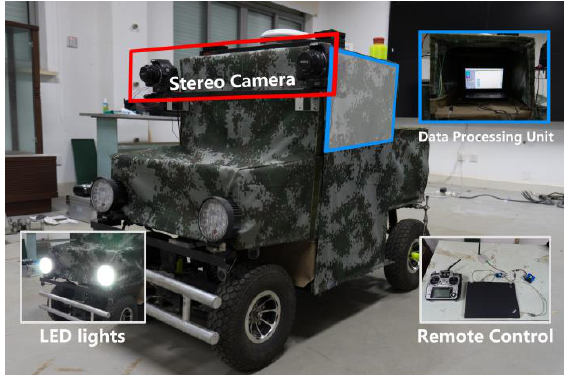
Figure 1. The appearance of the mobile mapping system The vehicle has an external dimension of 1.7m*0.7m*1m,